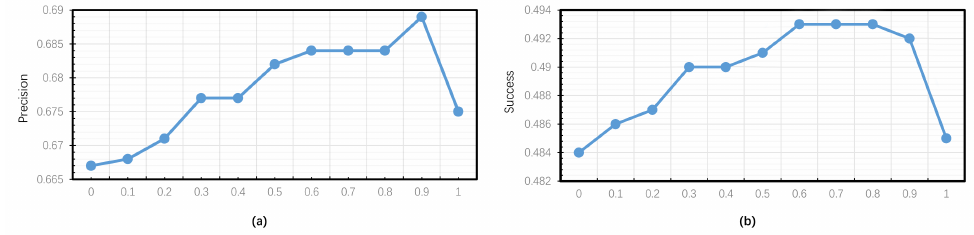
Figure 13. Effect of τ on the performance of ALCF. ( a ) shows the precision while ( b ) shows the success